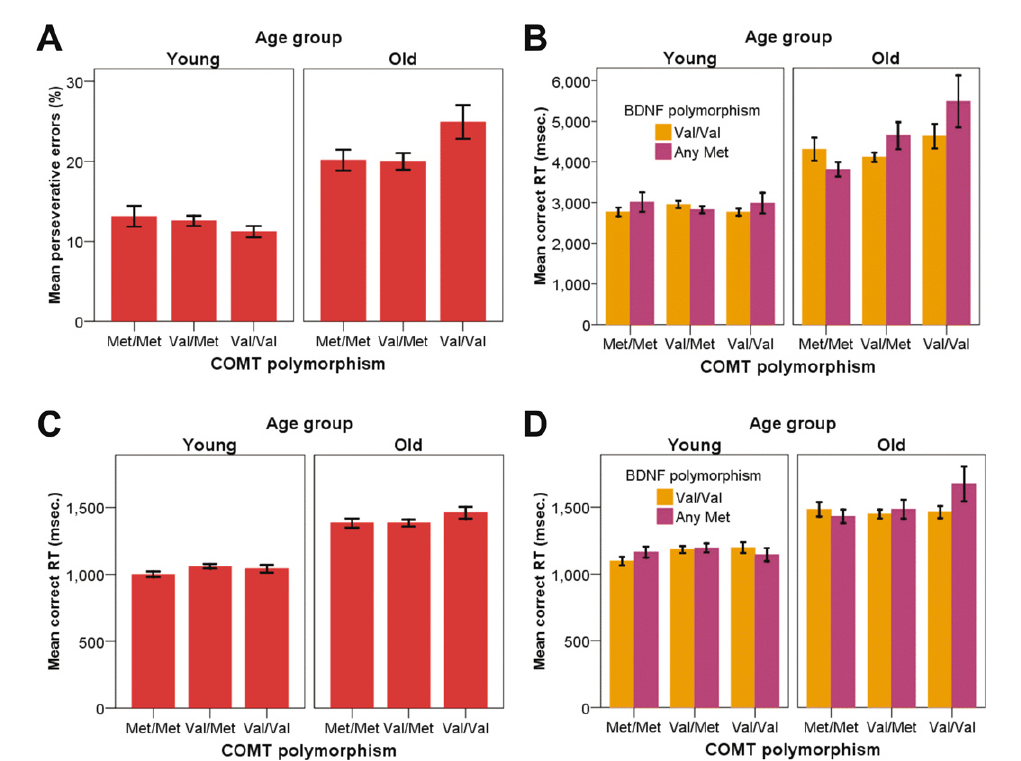
Figure 2. (A) Mean perseverative errors in the WCST as a function of age and COMT genotype. (B) Mean reaction time for correct WCST responses as a function of age, COMT genotype, and BDNF genotype. (C) Mean reaction time for correct SWM responses as a function of age and COMT genotype at load 4. (D) Mean reaction time for correct SWM responses as a function of age, COMT genotype, and BDNF genotype at load 7. Error bars represent standard errors around the means. WCST = Wisconsin Card Sorting Test; SWM = spatial working